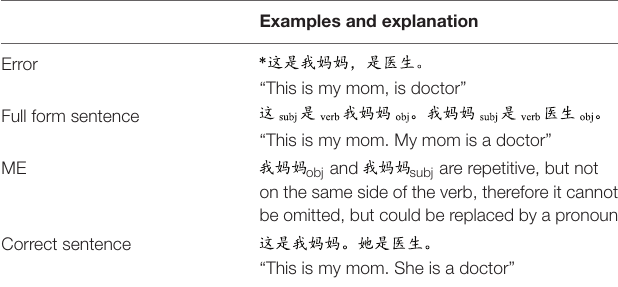
TABLE 7 | An example of metalinguistic explanation provided to participants in the study. Examples and